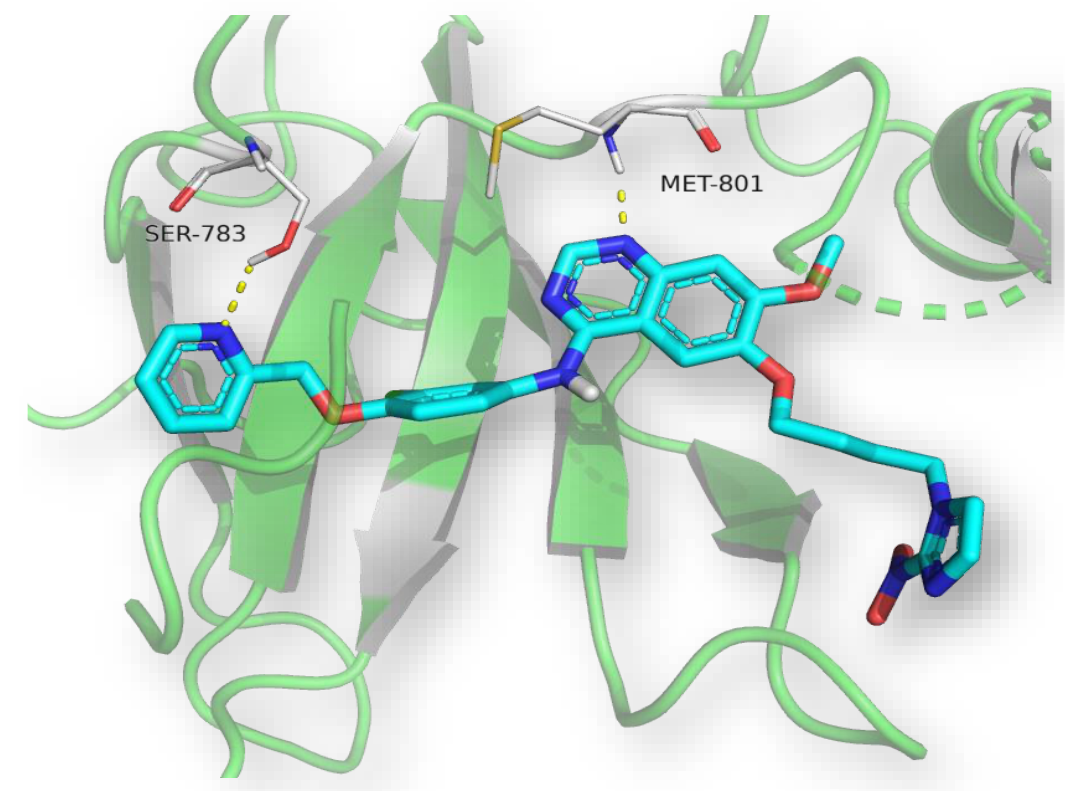
Figure 9. Compound 6j H-bond interactions with 3RCD residues.